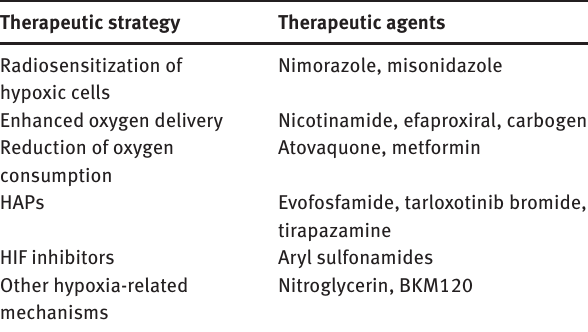
Table 1: Strategies to address hypoxia-mediated therapeutic challenges in